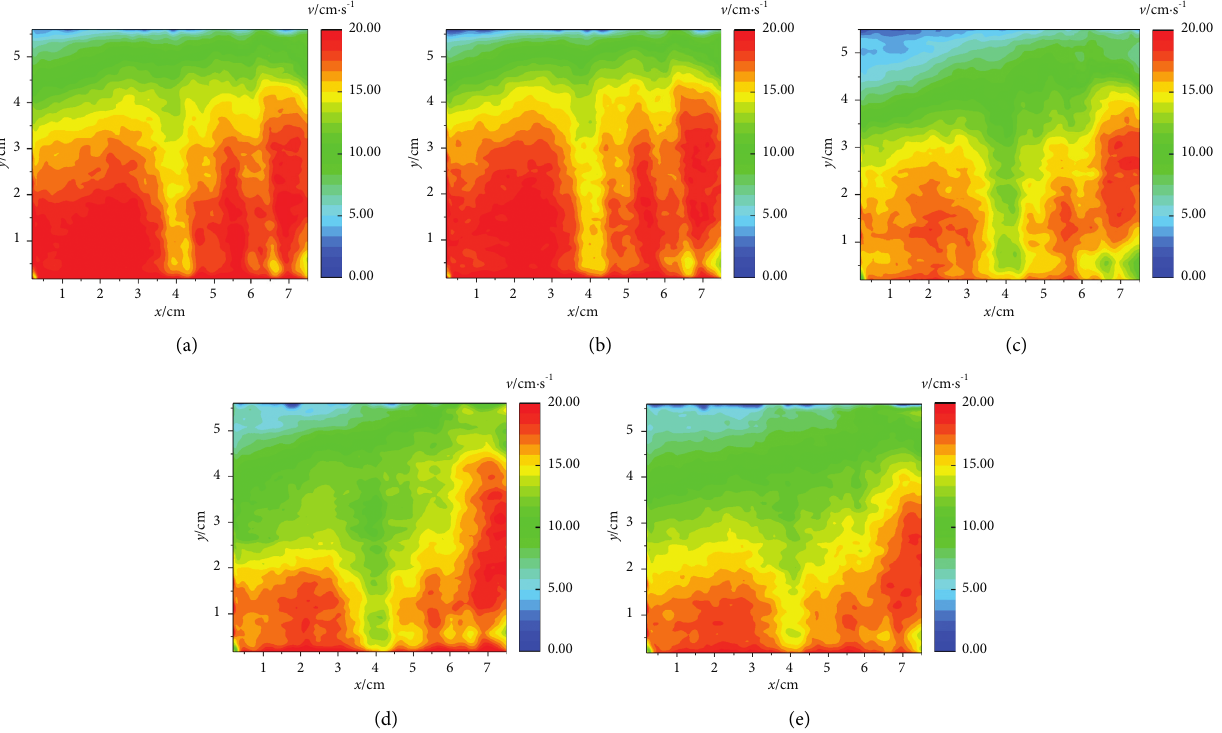
Figure 13: The distribution of the vertical turbulent intensities in different working conditions. (a) H25-1, (b) H25-1.2, (c) H25-1.5 (D252), (d) D251, and (e)